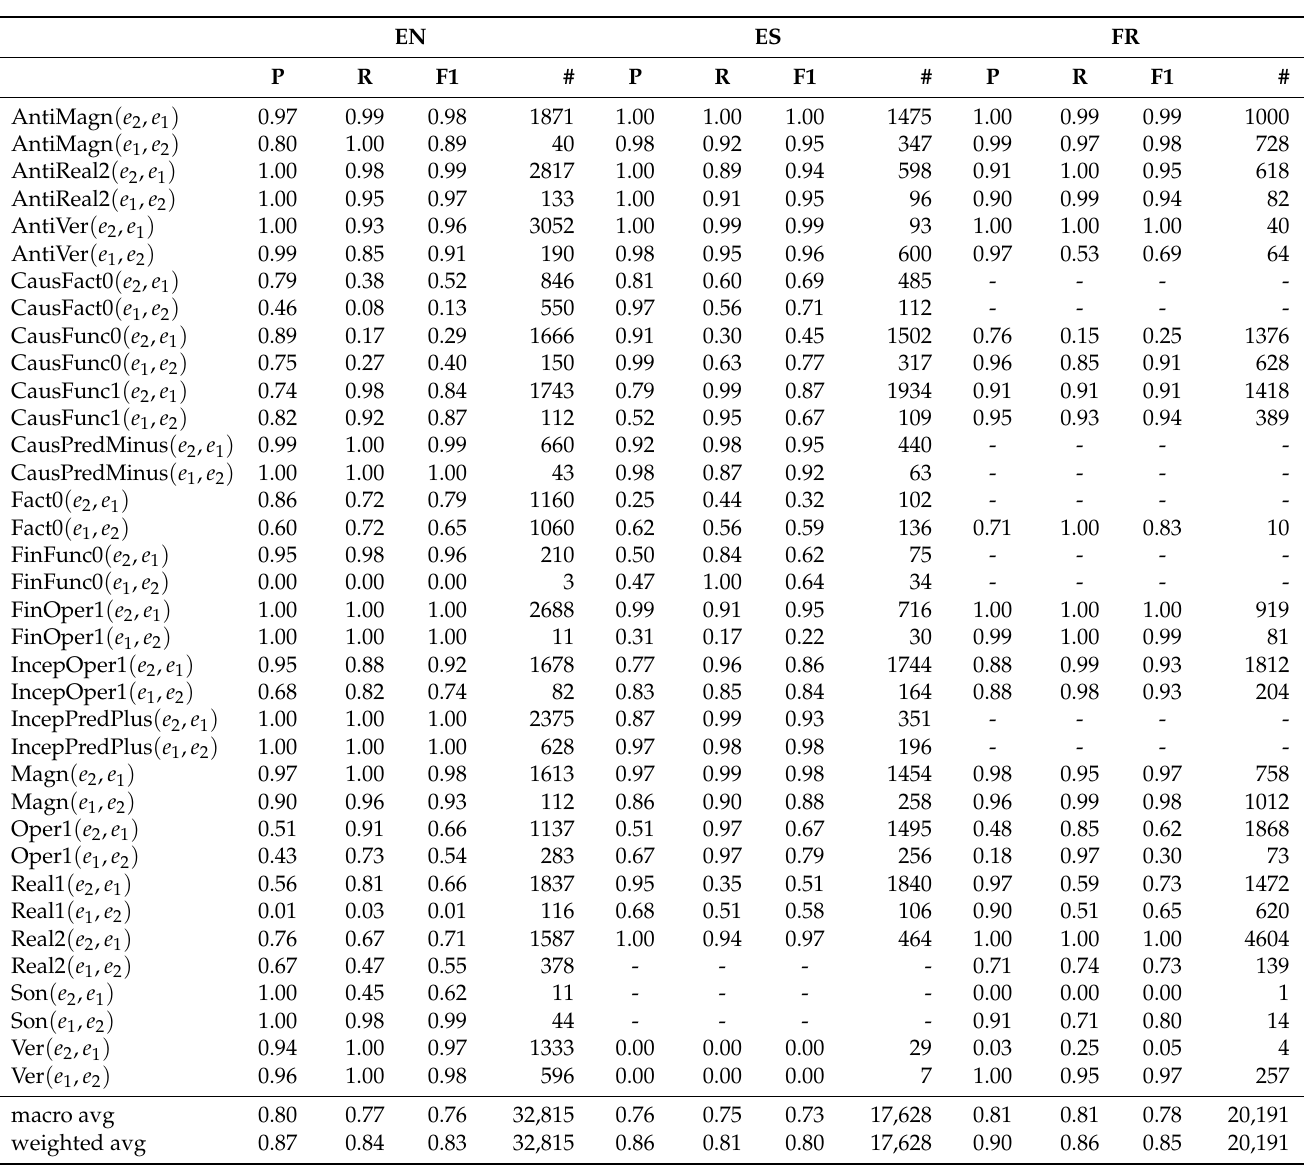
Table 4. Results breakdown per LF on the development set, where, for each LF, we list individual results for different order of bases and collocates in a